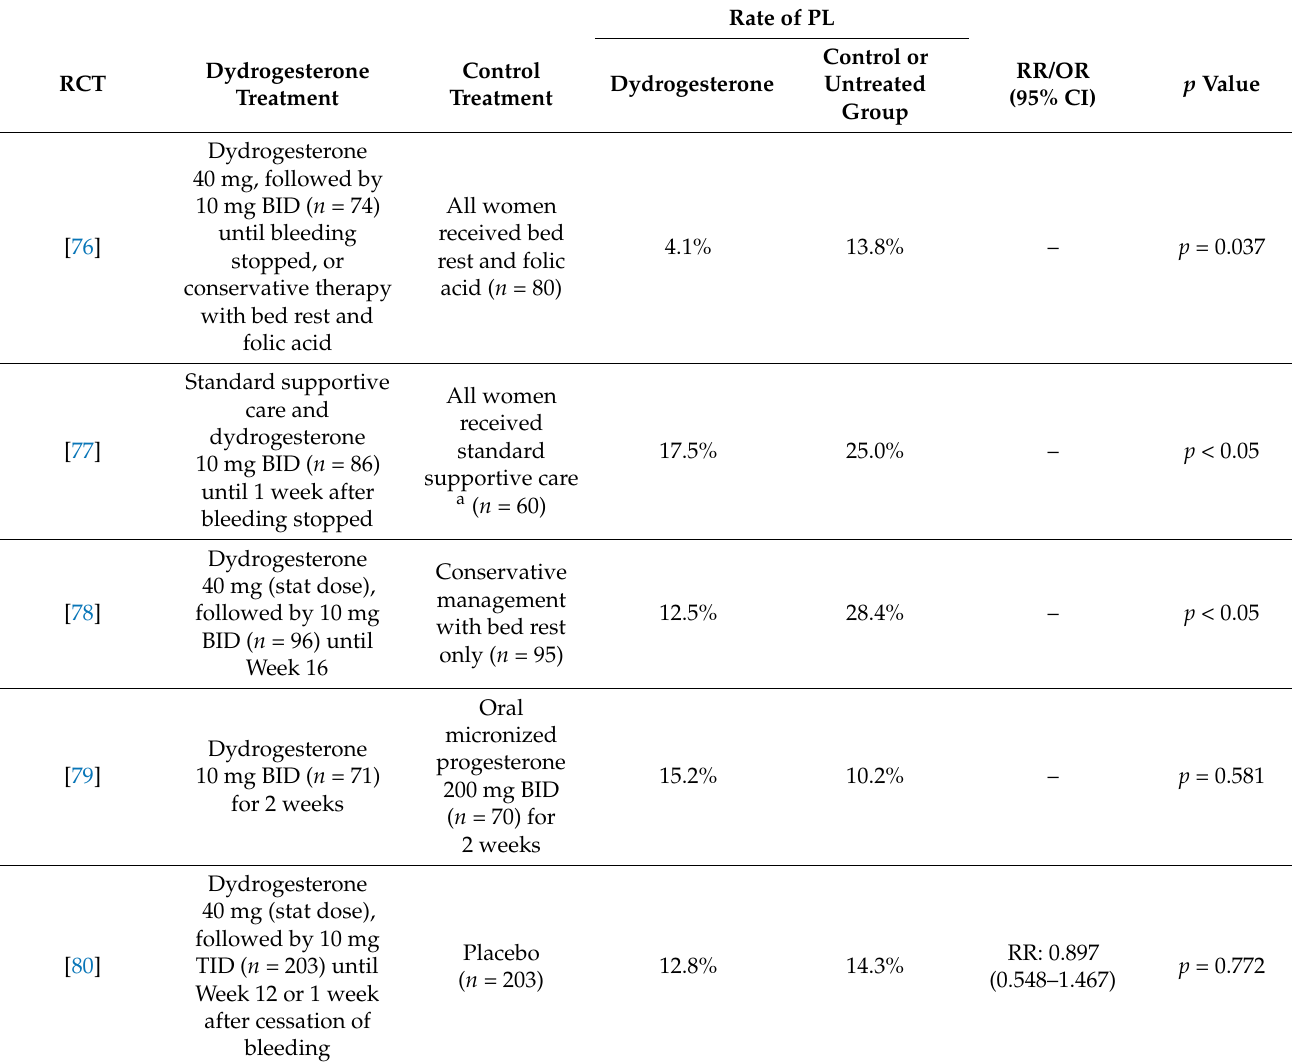
Table 2. Dydrogesterone in threatened pregnancy loss.